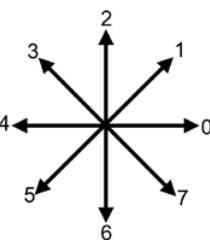
Figure 4: Eight-Direction Freeman Chain